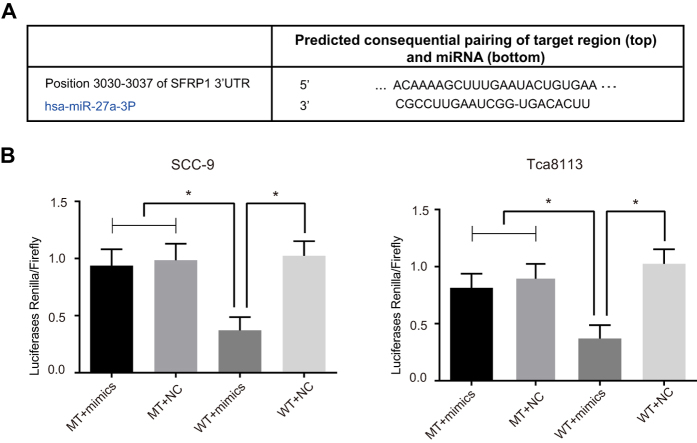
The luciferase activity in SCC-9 and Tca8113 cells in the WT + mimics, WT + NC, MT + mimics and MT + NC groups.(A) The binding sequence of miR-27a-3p and SFRP1. (B,C) The dual-luciferase reporter assay to examine whether miR-27a-3p targets SFRP1; *represents P < 0.05 comparisons with the WT + mimics group. SFRP1, secreted frizzled-related protein 1; WT, wild type; MT, mutant type.